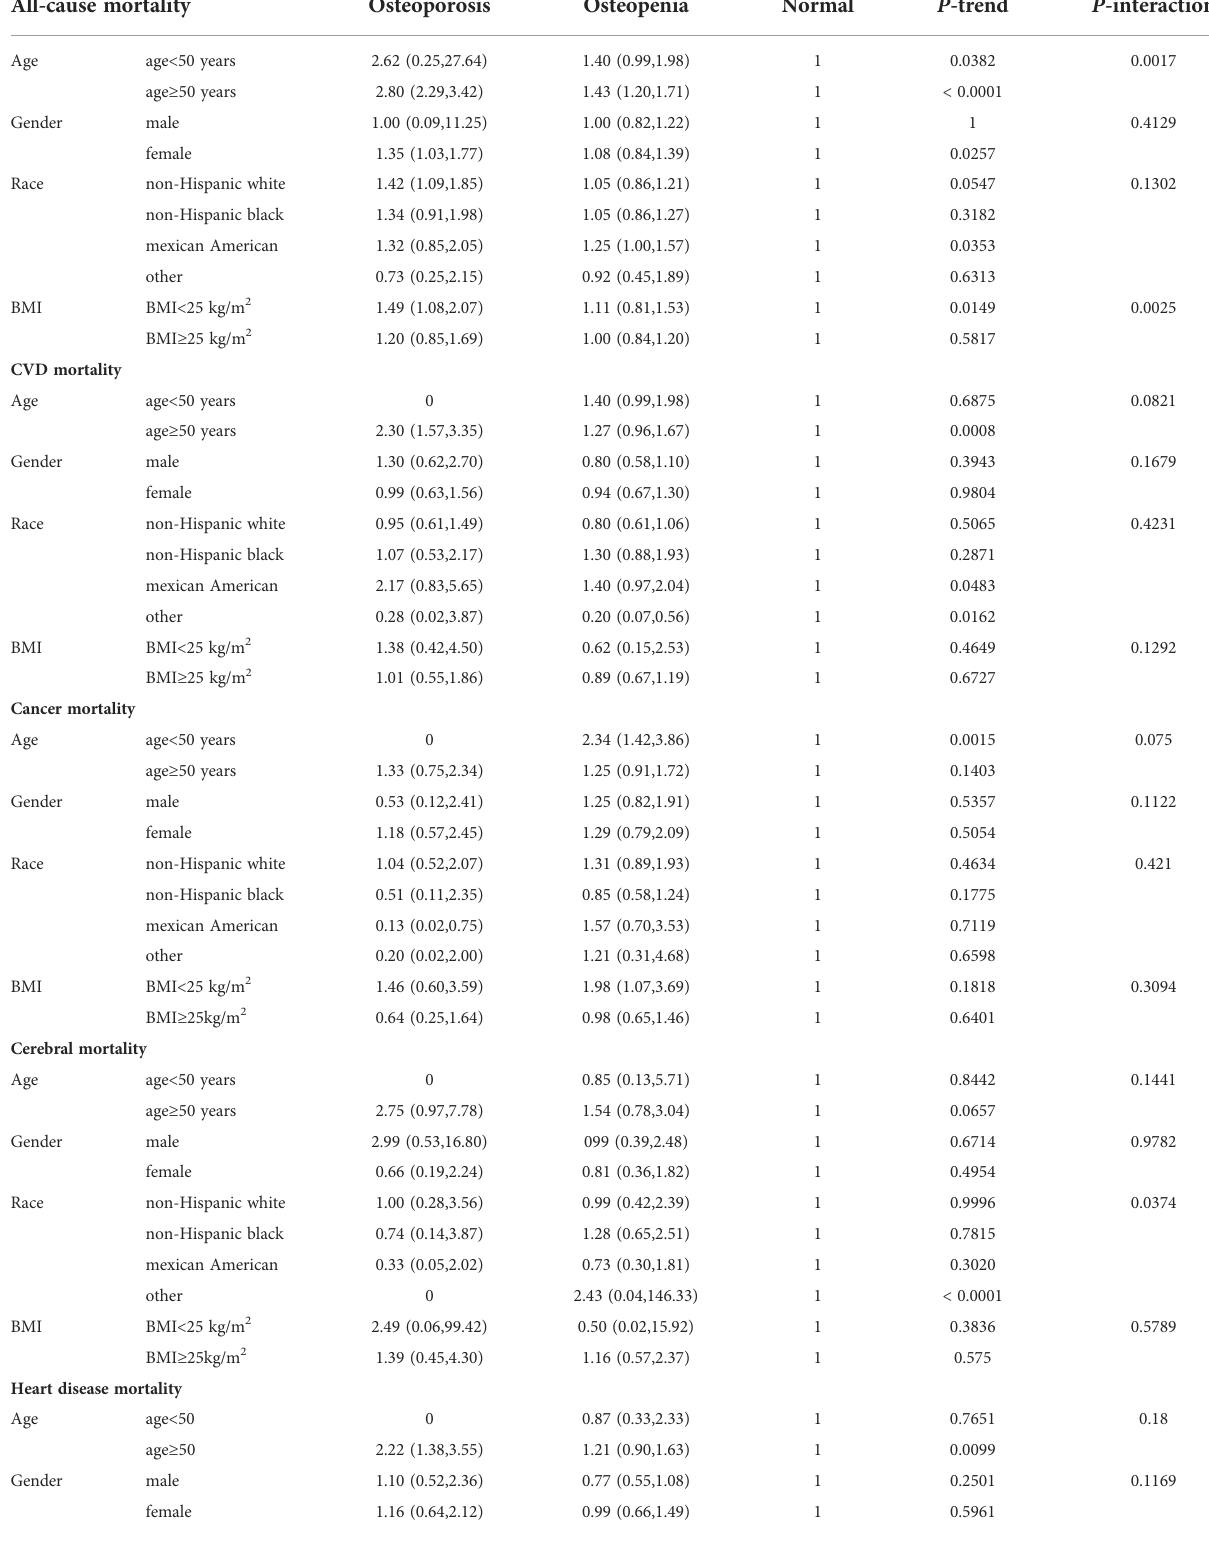
TABLE 3 Subgroup analysis for CVD, cancer and all-cause mortality according to the groups of bone mineral density (mg/cm2). All-cause